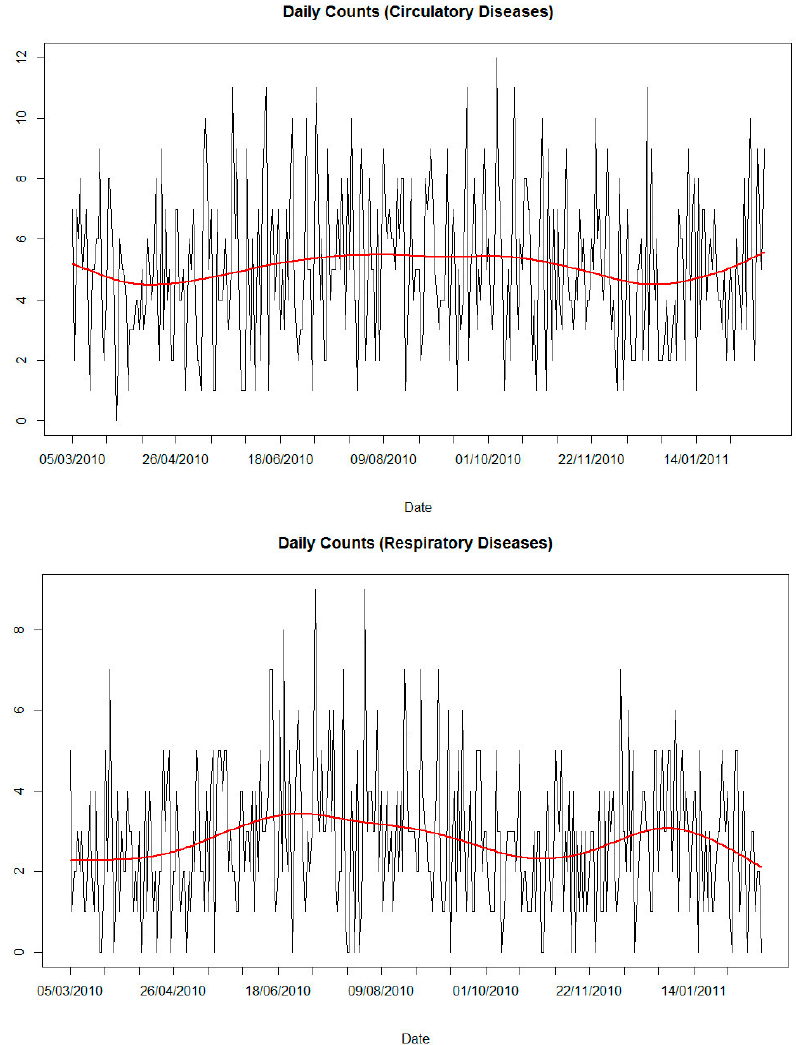
Figure 2. Number of hospital admissions of elderly people ( ≥ 60 years old) due to circulatory and respiratory diseases per day from 5 March 2010 to 17 February 2011. Line, smoothing spline with 3 degrees of freedom relative to the circulatory diseases and 4 degrees of freedom relative to the respiratory diseases.